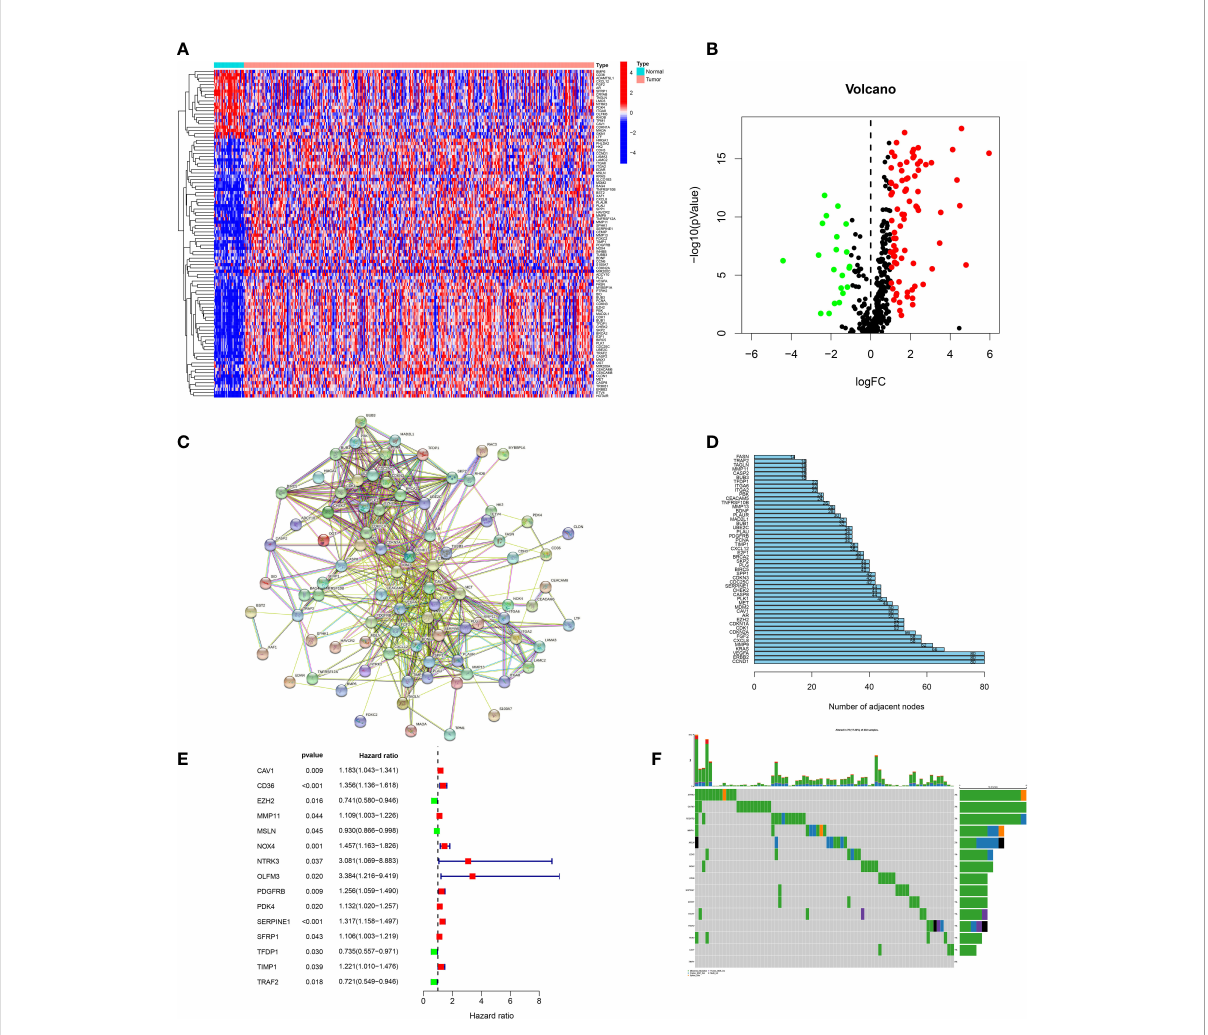
FIGURE 1 Screening of candidate genes. (A) Heatmap of DEGs between tumor specimens and normal specimens. (B) A volcanic plot of DEGs between tumor specimens and normal specimens. (C) The PPI network of DEGs. (D) The number of nodes of hub genes in the PPI network. (E) Forest plot of genes associated with prognosis. (F) Mutations of prognostic